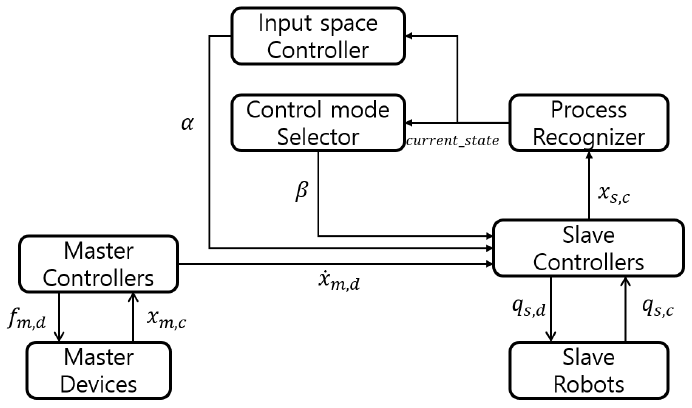
Figure 2. Schematic showing position–rate hybrid teleoperation control. Predetermined input space vector α and control mode β are listed in Tables 1 and 2.